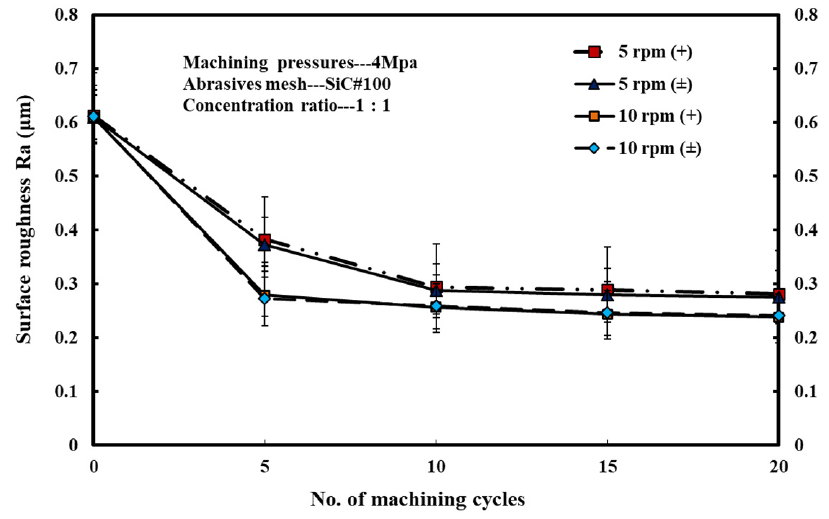
Figure 8. Effects of rotation direction on surface roughness.